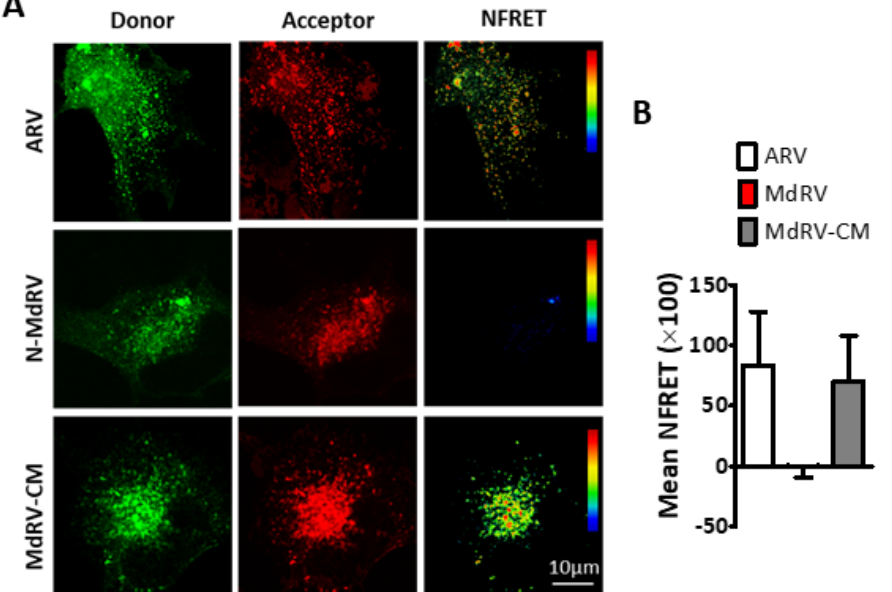
Figure 7. The ARV p10 CM restores MdRV p10 multimerization. ( A ) QM5 cells were co-transfected with C-terminally EGFP- and mCherry tagged versions of the indicated p10 constructs and analyzed for sensitized emission FRET. Images from the donor and acceptor channels and the calculated normalized FRET (NFRET) image are shown. The NFRET range is denoted by color gradations. ( B ) Best-fit Gaussian distributions of calculated NFRET images from 10 cells in each of the two separate experiments were used to calculate mNFRET values, presented as mean ± SEM, from cells co-transfected with fluorescently tagged versions of the indicated p10 constructs.